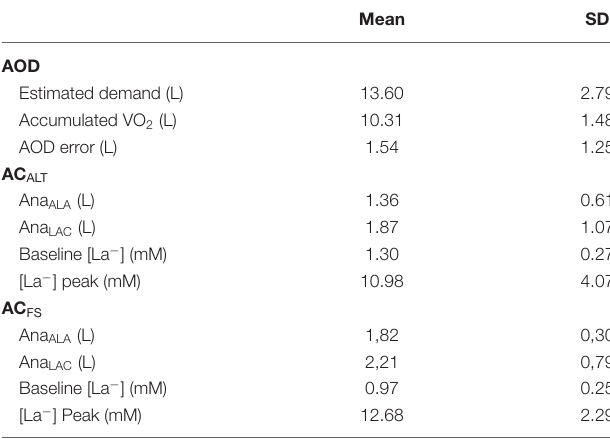
TABLE 2 | Mean ± standard deviation (SD) of accumulated oxygen deficit (AOD), alternative anaerobic contribution (AC ALT ), and free-swimming anaerobic contribution (AC FS ) parameters ( n =